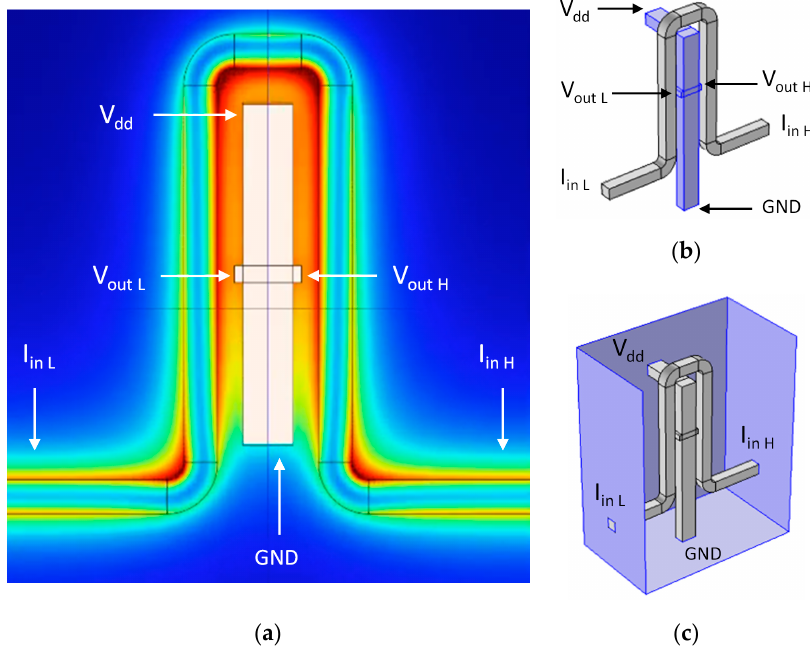
Figure 5. Hall Amplifier Nanoscale Device (HAND) two-dimensional (2D) structure in Comsol. ( a ) With activated field. ( b ) 3D view. ( c ) In simulation box.